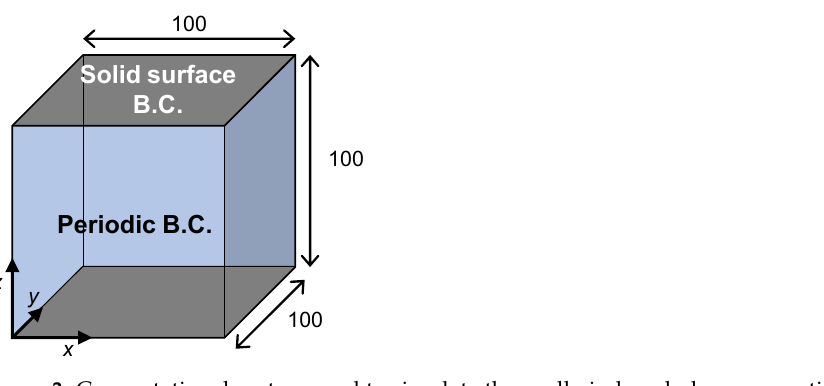
Figure 3. Computational system used to simulate thermally induced phase separation (TIPS) of a polymer solution with a solid surface boundary condition (B.C. in the figure) for the top and bottom boundaries and periodic boundary conditions for the side boundaries.